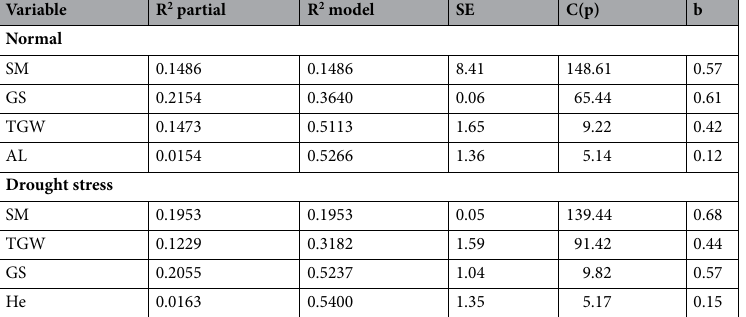
Table 4. Results of stepwise regression analysis for traits associated with grain yield in synthetic hexaploid wheat derived lines under normal and water stress conditions. SM, spike per m 2 ; TGW (g), thousand-grain weight; GS, grains per spike; AL, awn length; He, hectoliter (kg/he); SE, standard error; R 2 , the coefficient of determination showing the contribution of each trait to grain yield variation; C(p), Mallow’s cp statistic; b, coefficient of regression.